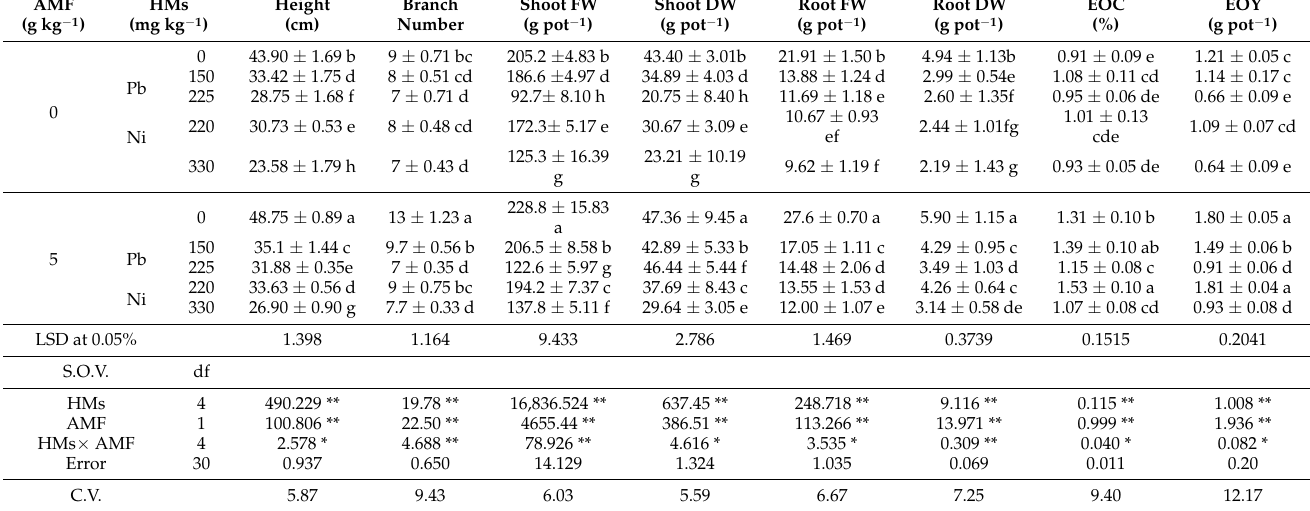
ns, * and ** indicate no significant difference, significant at 5% probability level and significant at 1% probability level, respectively. S.O.V. and df refer to the source of variation and degree of freedom. Different letters in columns indicate a significant difference at p ≤